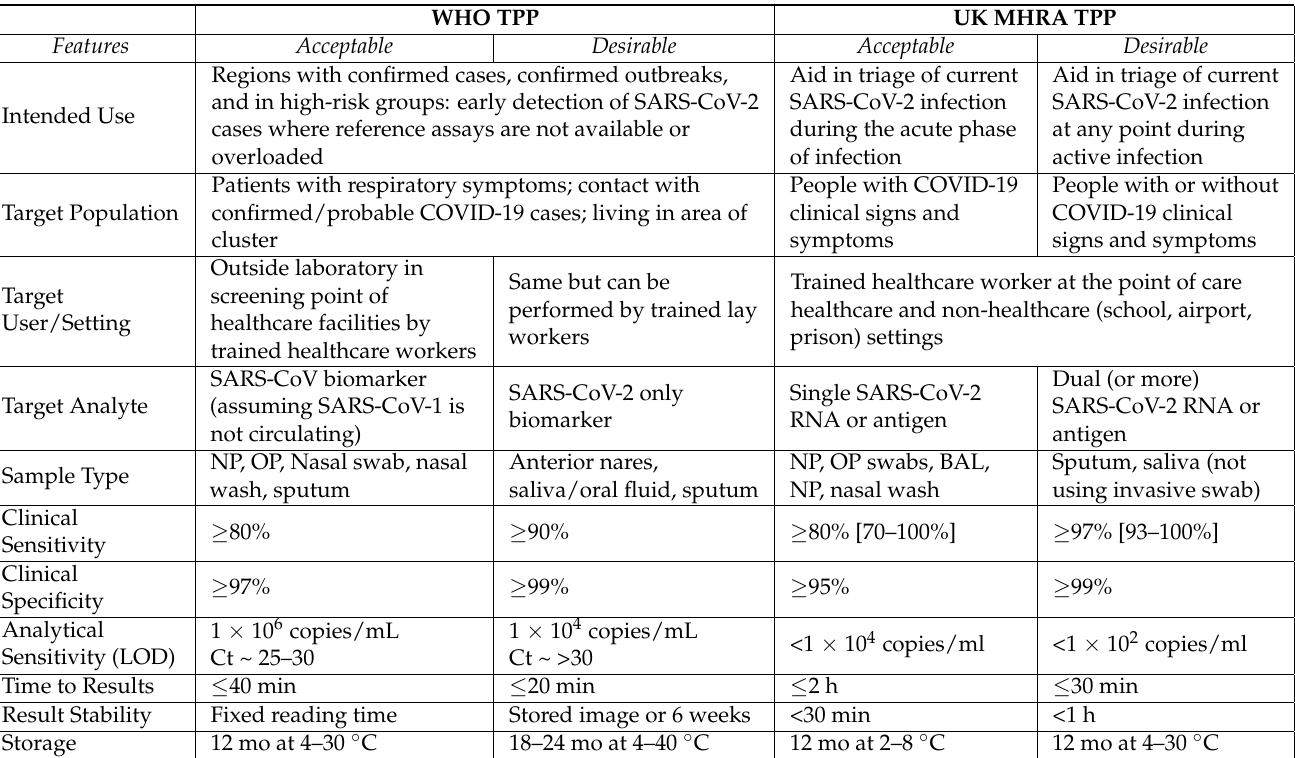
Table 1. Target product profiles (TPP) summary. Point-of-care rapid tests to detect SARS-CoV-2 infection.